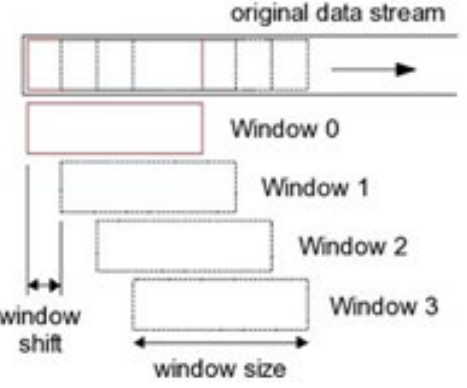
Fig. 5. Concept of window size and window